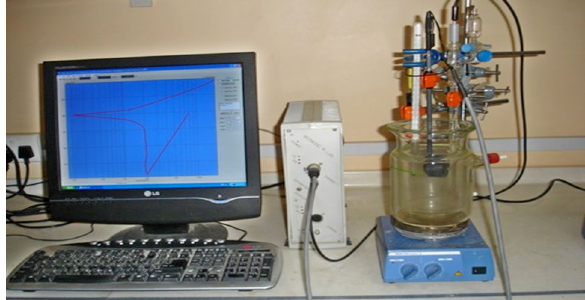
Figure 3. XRD analysis results of sintered (Al-4.5% Cu-1.5% Mg)